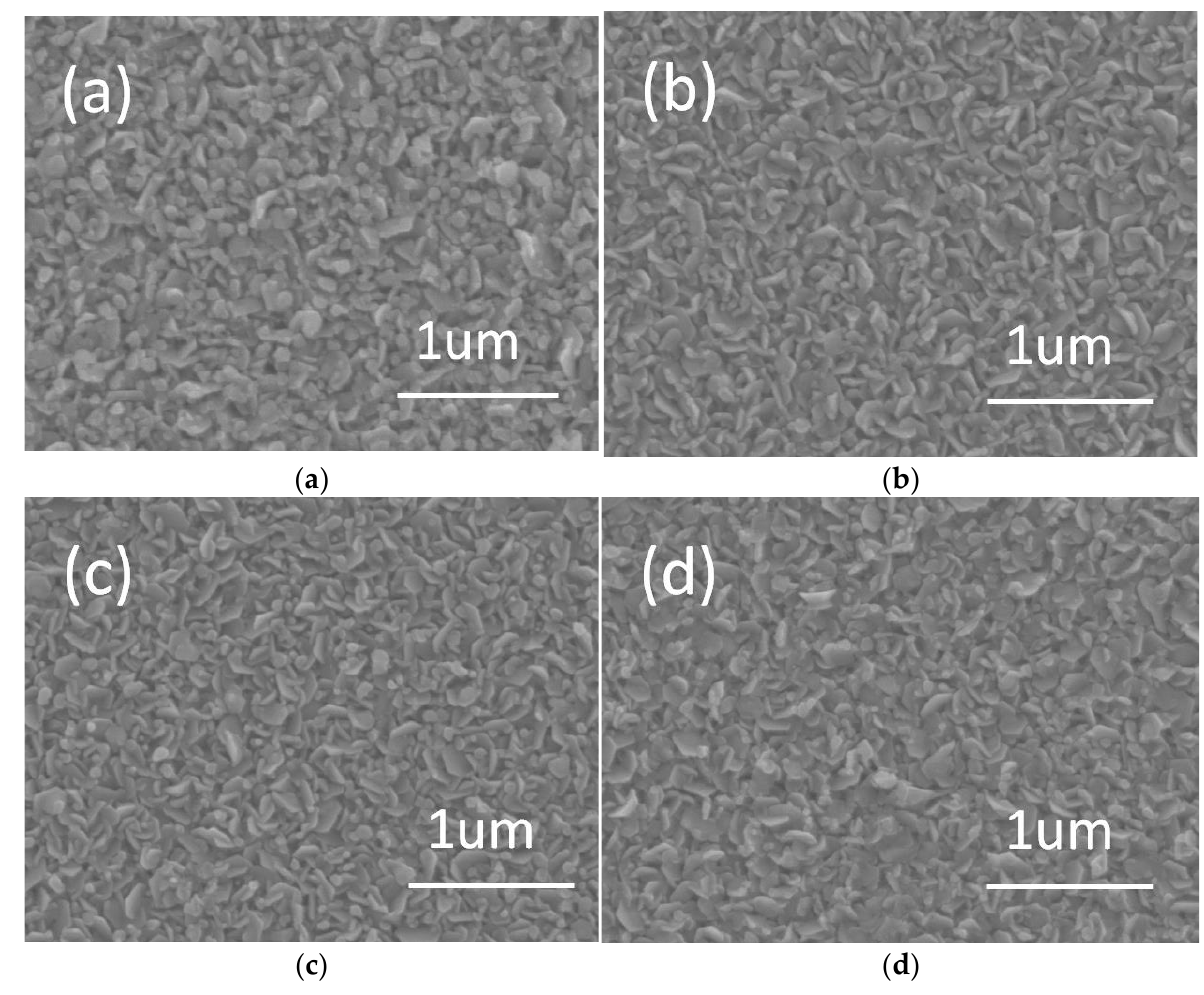
Figure 5. Surface morphology of samples ( a )AT0, ( b ) AT1, ( c ) AT3, and ( d ) AT7. Figure 6 shows the current − voltage (I − V) characteristics of samples AT0, AT1, AT3, and AT7 measured at room temperature. In the forward bias region, a little increase in the turn-on voltage with the introduced and increased Ga 2 O 3 thickness can be observed for samples AT0 to AT7. For a pn diode considering the series resistance, the ideality factor η as [35] I